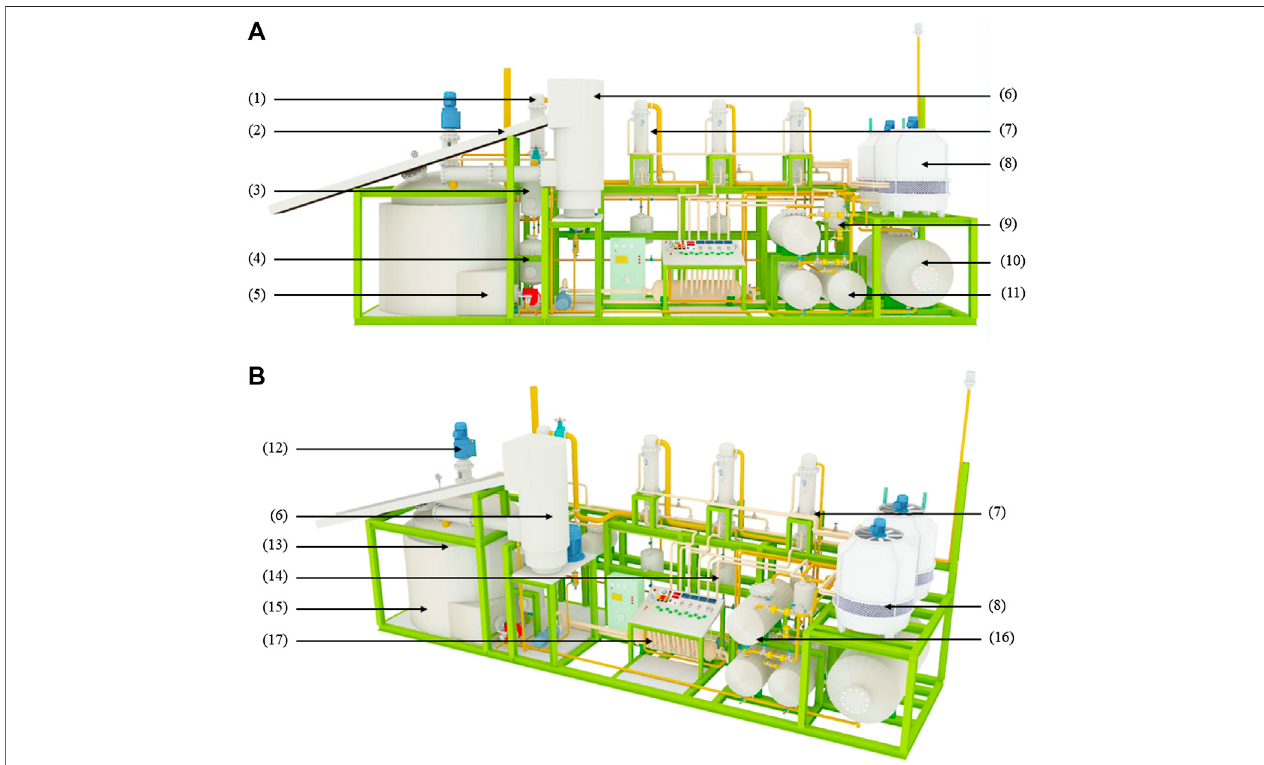
FIGURE5| Three-dimensionalmodelofthemobilepyrolysisequipmentsetThree-dimensionalmodelofthemobilepyrolysisequipmentsetwhen (A,B) consistsof (1)Cyclone,(2)Wasteconveyorbelt,(3)Firstgasseparator,(4)Gasstoragetank,(5)Burner,(6)Sub-machinefeeder,(7)Condenser,(8)Coolingmachine,(9)Secondgas separator, (10)Coolingwatertank,(11)Pyrolysisoil storage tank,(12)Gearmotorstirring set,(13)Kilns, (14)Product fi lters,(15)Reactor,(16)Pyrolysis oilstorage tanks, and (17) Coolant.